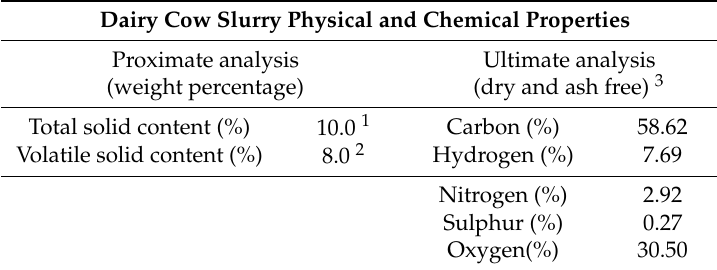
Figure 1. DEFRA livestock map for the area under study. Table 1. Physical and chemical properties for dairy cow slurry.